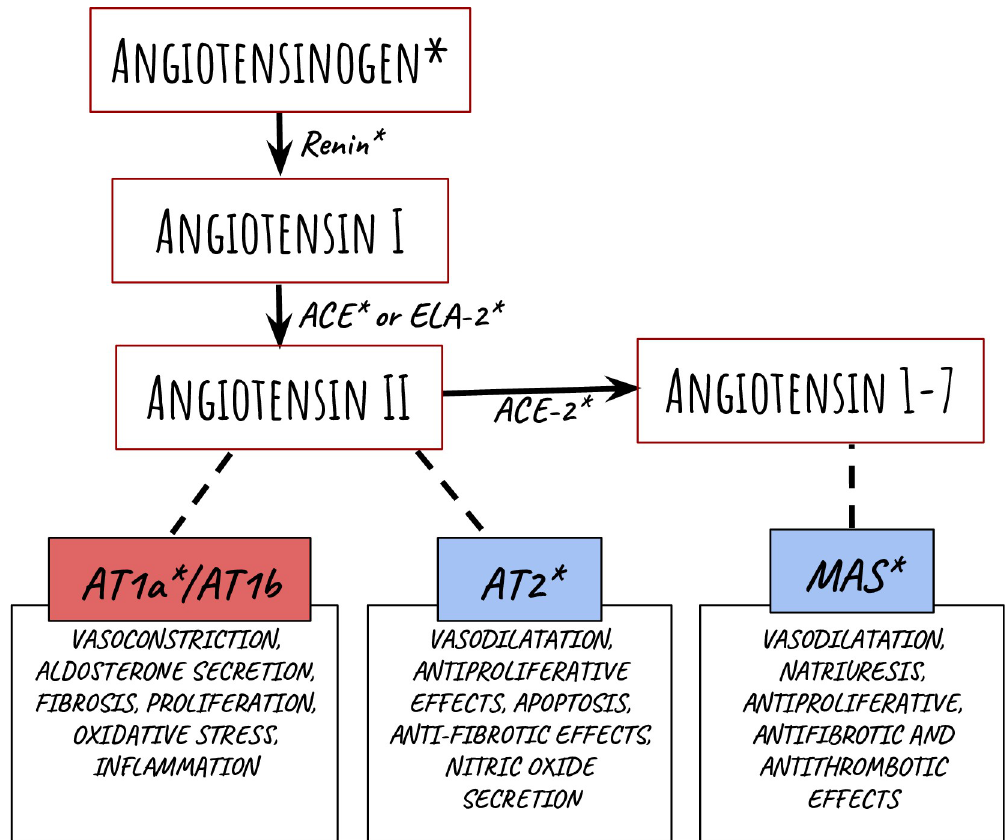
Fig 1. Representation of the metabolic RAS cascade. Angiotensinogen and the peptide sequences are shown as a result of specific enzyme cleavages, which are included next to their represented arrows. The receptors are represented as boxes on the bottom and the function described is a result of the linked angiotensin binding. The RAS targets used in this study are indicated with an asterisk. Graphic illustration is adapted from Ferrario and Strawn [1].